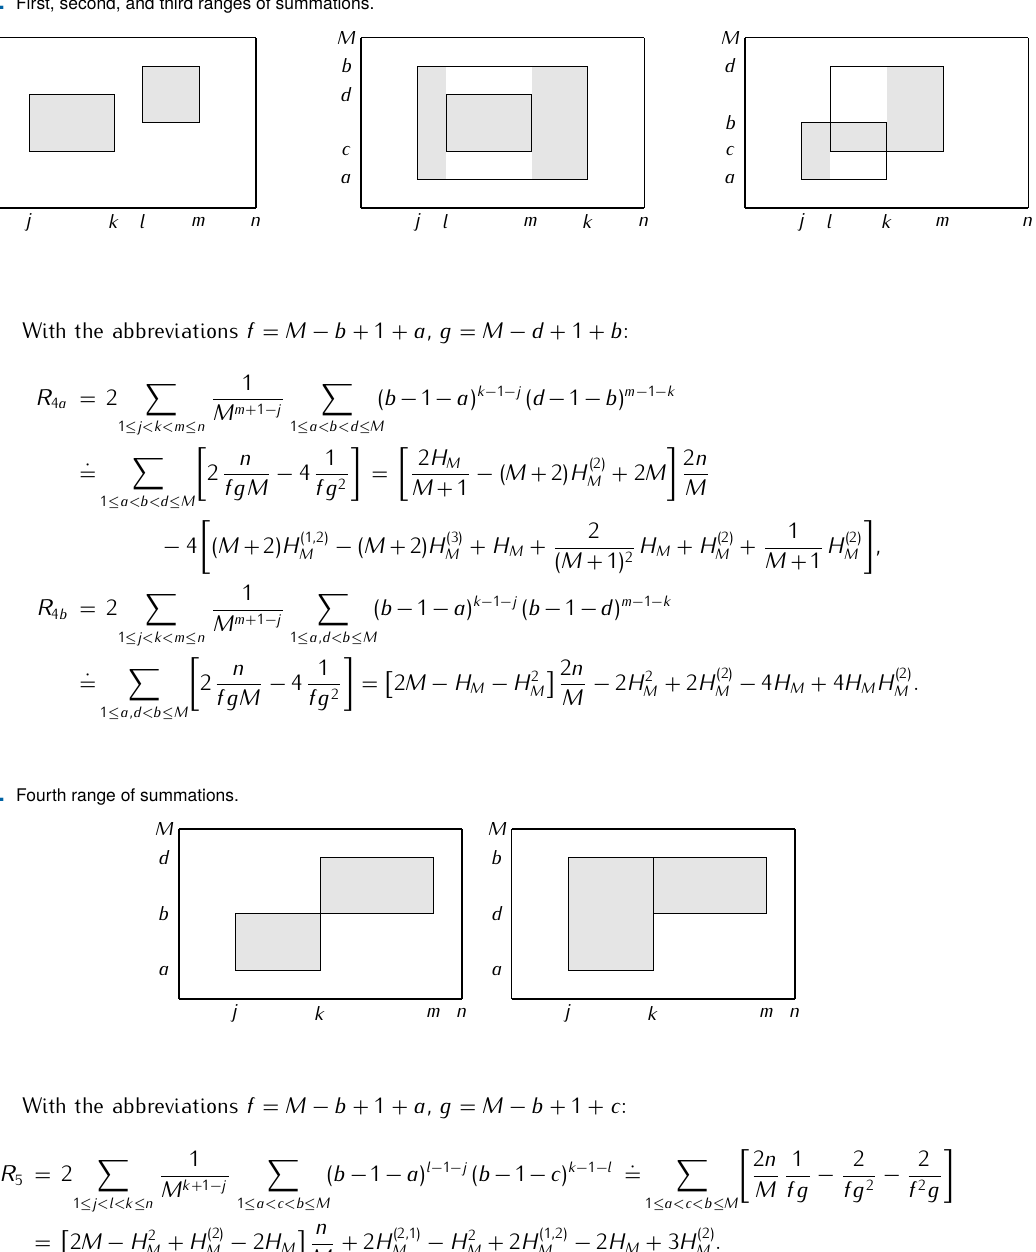
Figure 1. First, second, and third ranges of summations.